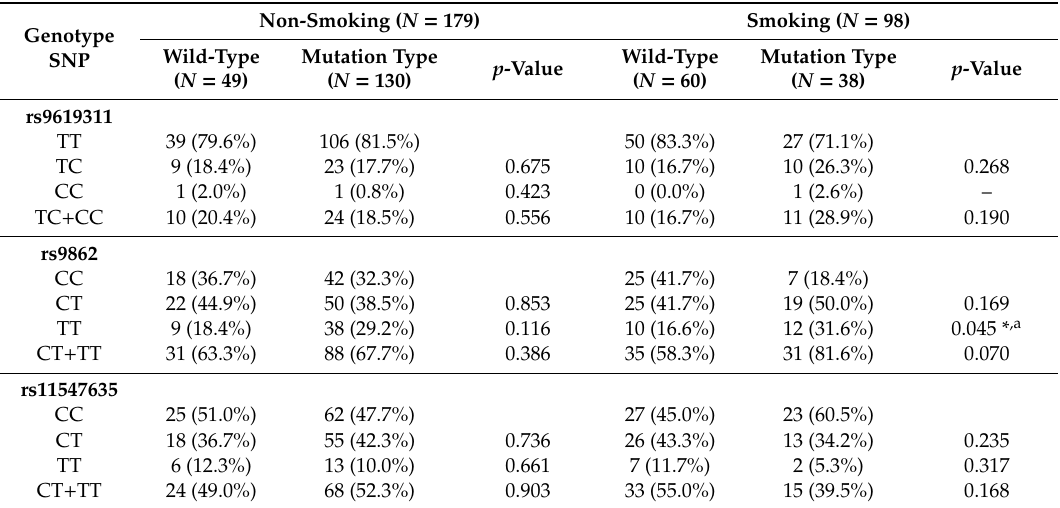
Table 3. Distribution frequencies of tissue inhibitor of metalloproteinases (TIMP)-3 genotypes of lung adenocarcinoma patients with di ff erent cigarette smoking statuses and multiple logistic regression analysis of epidermal growth factor receptor (EGFR) mutation associations.